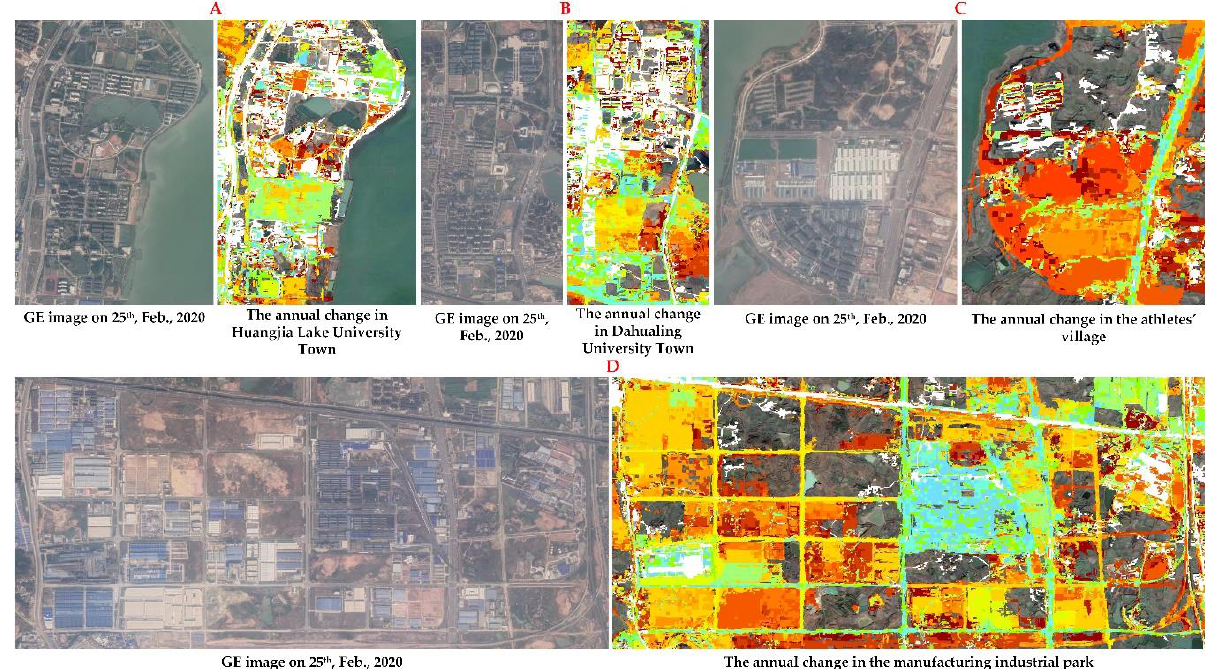
Figure 9. The annual change of impervious surface maps in typical regions of Daqiao New Town shown in more detail than in Figure 8. ( A ): Huangjia Lake University Town; ( B ): Dahualing University Town; ( C ): the athletes’ village of the 7th Military World Games, ( D ): the manufacturing industrial park. GE: Google Earth.